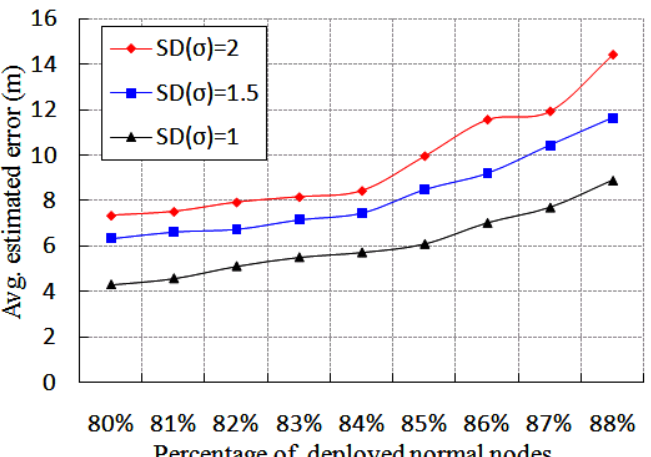
Figure 8. Effect of Standard Deviation (SD) on localization error for different number of normal